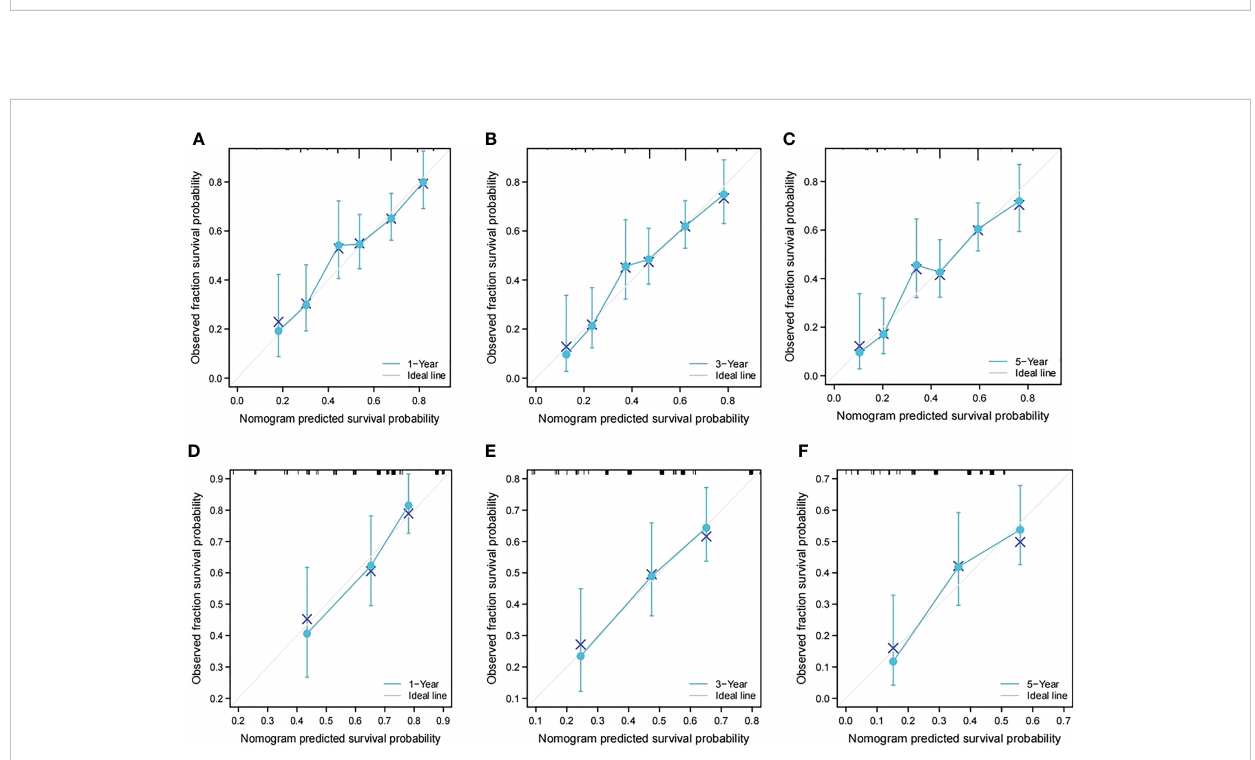
FIGURE 4 Calibration curves of the prognostic nomogram in both groups. (A) Calibration curve of the nomogram for the training cohort at 1 year. (B) Calibration curve of the nomogram for the training cohort at 3 years. (C) Calibration curve of the nomogram for the training cohort at 5 years. (D) Calibration curve of the nomogram for the validation cohort at 1 year. (E) Calibration curve of the nomogram for the validation cohort at 3 years. (F) Calibration curve of the nomogram for the validation cohort at 5